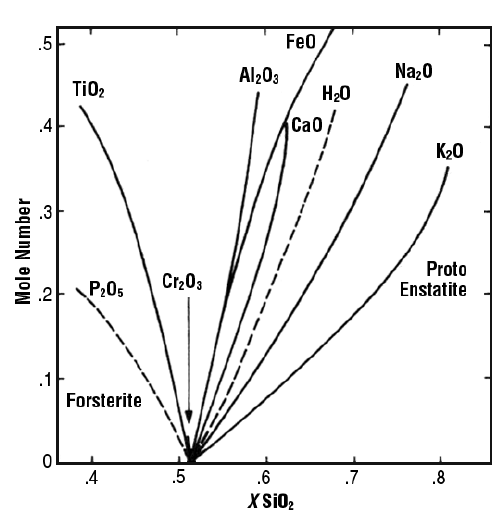
Fig. 4. Effects of different added oxides on the forsterite-enstatite-liquid equilibrium (after Kushiro, 1973).